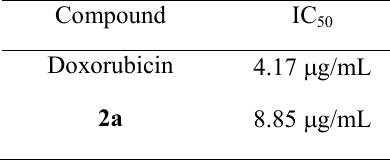
Table 2. Effect of some selected newly synthesized compounds on breast cancer cell